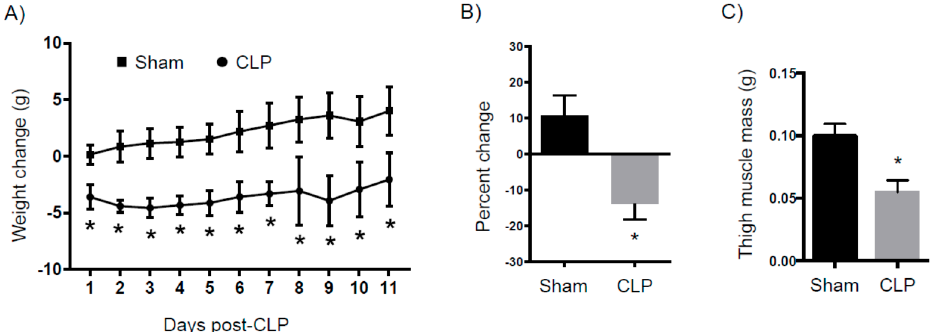
Figure 5. Weight changes after CLP. Mice were subjected to either sham surgery or CLP. Mice were then weighed daily for eleven days. Groups were then compared in terms of ( A ) absolute change in weight and ( B ) maximum percent weight change compared to baseline ( N = 12 for both groups). ( C ) In another set of experiments, animals were sacrificed after eight days and their thigh muscles were weighed ( N = 6 for both groups). * p < 0.05 versus sham.